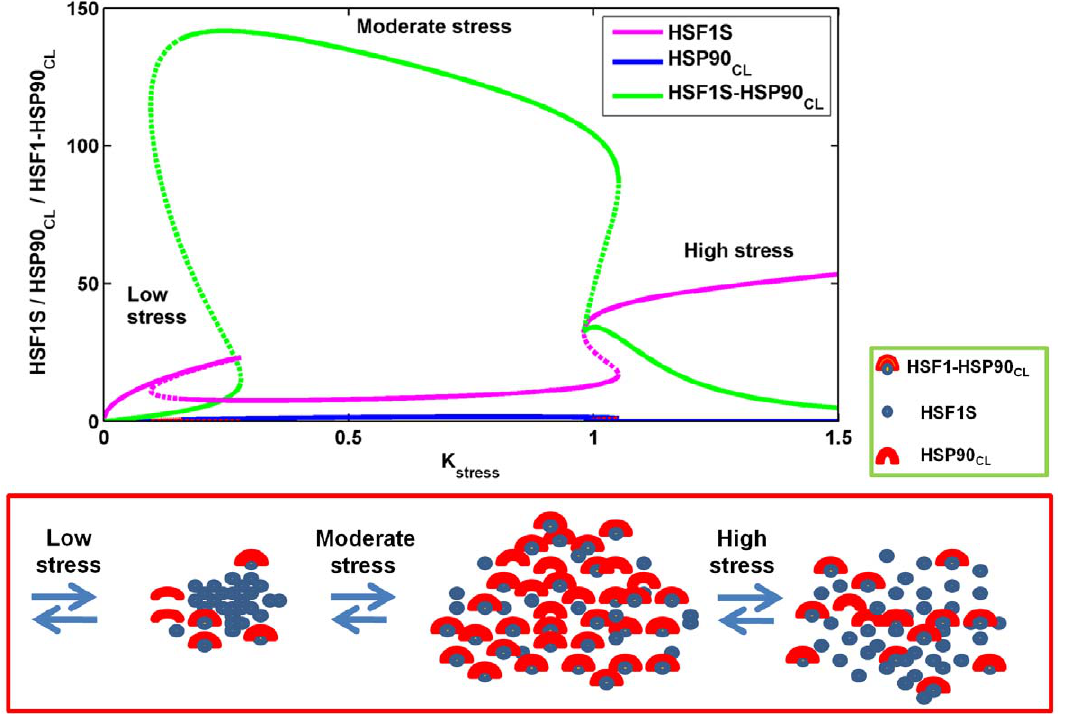
Figure 9. Dynamics of stress-initiated molecular events in heat-shock protein 90 (HSP90) production. Three different levels of stress, low, moderate, and high, are considered in mapping the molecular events that drives the mushroom dynamics of the HSP90 network using the bifurcation diagram. An illustration of the molecular events corresponding to the occurrence of mushroom dynamics in terms of heat-shock factor 1 monomer (HSF1S, blue filled circle), the closed conformation of heat-shock protein 90 ( HSP90 CL , in yellow-filled red semicircle) and HSF1S : HSP90 CL complex (in yellow-filled red semi-circle bound to blue filled circle) are shown in the lower panel. A low level of stress increases the inactive HSF1, and converts it rapidly into an active form, HSF1S. HSP90 CL is present at a low level due to the time taken for its production. An increase in stress to a moderate level results in further production of active HSF1S. This in turn oligomerizes, and through a sequence of PdP reactions, produces more HSP90 CL . This negatively regulates its own production by rapidly forming a complex with the inactive HSF1 monomer, and results in a drastic reduction of its own concentration. For a very high stress level, HSF1 : HSP90 CL complex breaks down rapidly, and the inactive HSF1 is again converted into a more active form,